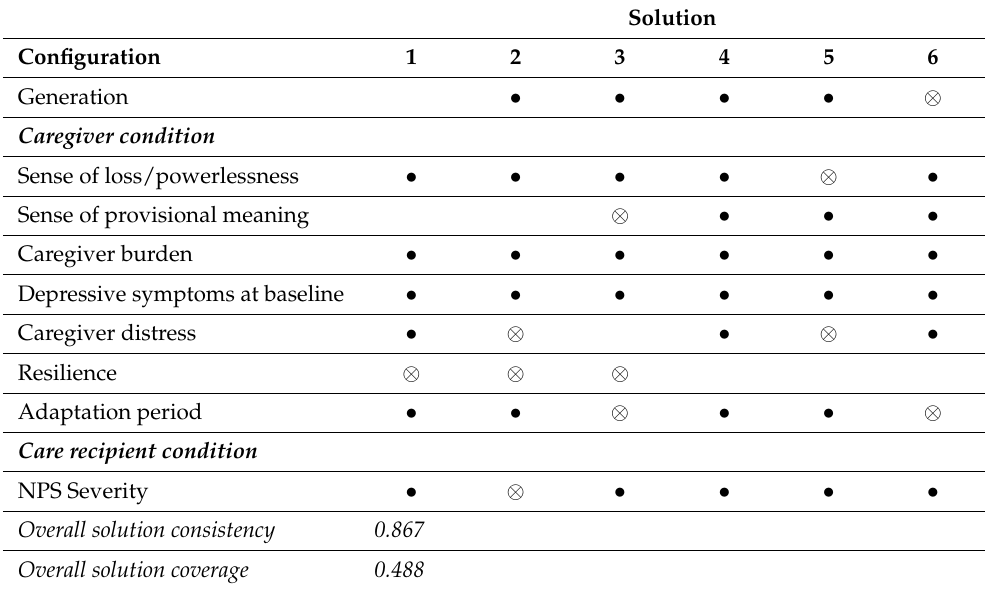
Table 3. fsQCA findings towards high depressive